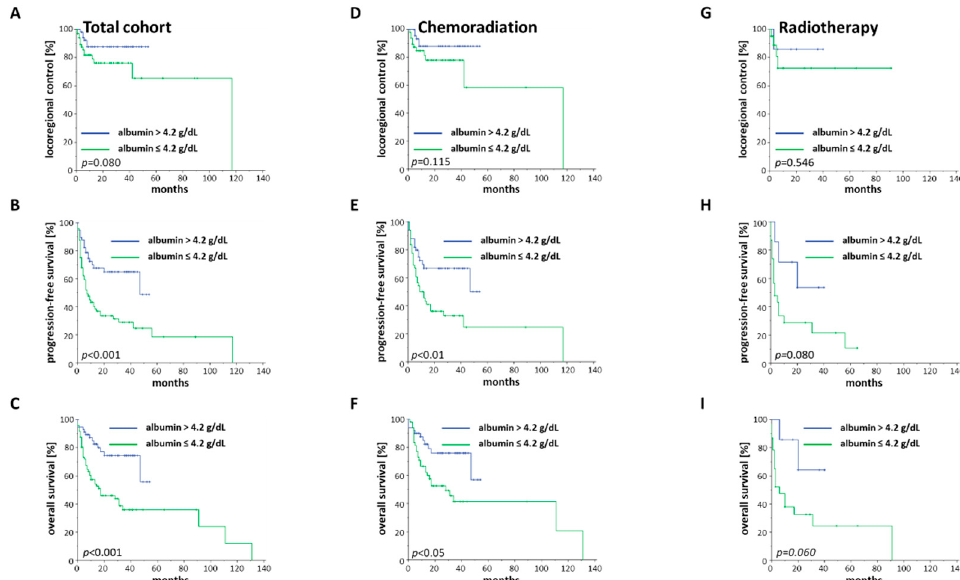
Figure 5. LRC, PFS and OS of elderly HNSCC patients in dependence of the baseline albumin serum level ( A – C ) Kaplan–Meier curves for the entire cohort with existing albumin serum values ( n = 129). ( D – F ) Kaplan–Meier curves of all patients undergoing chemoradiation who had available albumin values ( n = 99). ( G – I ) Kaplan–Meier curves showing all patients who were treated with radiotherapy and had available albumin values ( n = 30). p -values of log-rank tests are shown.